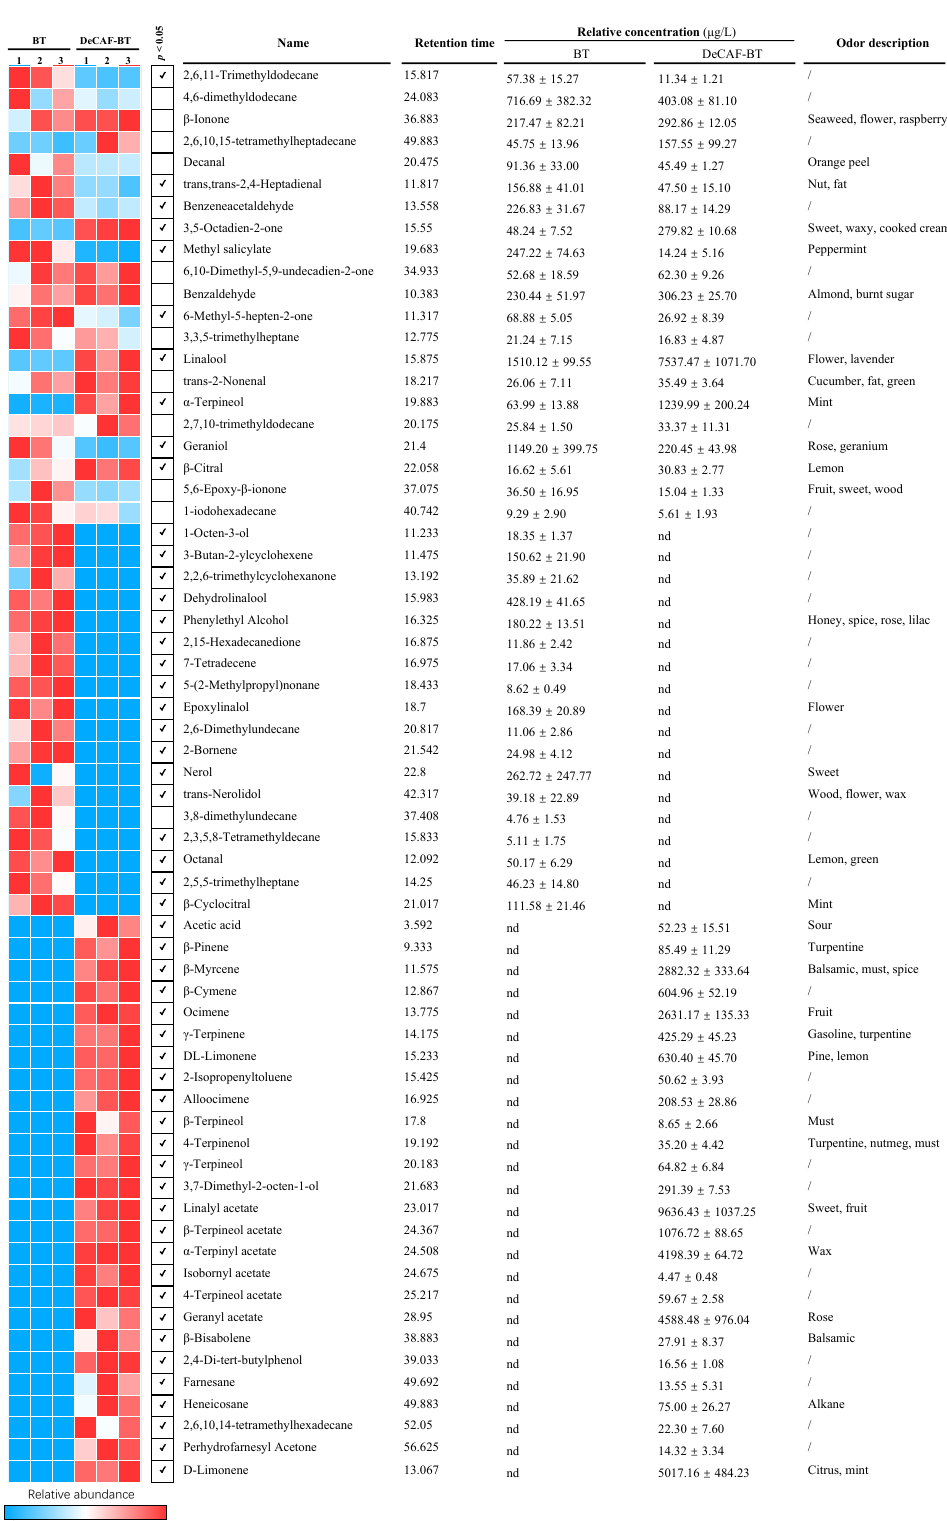
Figure 4. Non-volatiles in the black tea (BT) and decaffeinated black tea (DeCAF-BT). Notes: the odor description was referenced from http://www.flavornet.org (accessed on 10 September 2022). The blue and red squares indicate the relative abundance of volatiles from 0 to 1, respectively. Abbreviations: not detected